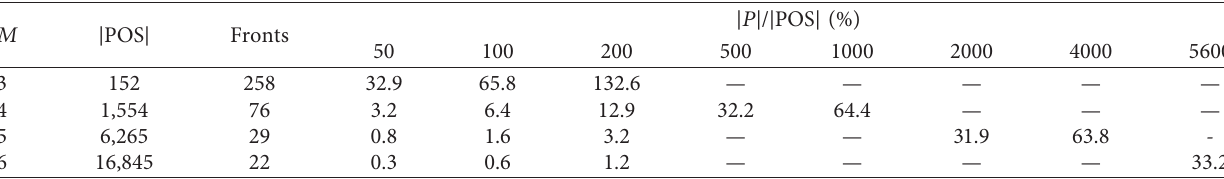
Table 2: Number of solutions in the Pareto optimal set | POS | and nondominated fronts in the landscapes with M � 3 , 4 , 5, and 6 objectives. Also, fraction of | P | / | POS | (in %) for various population sizes | P | investigated in this study. A — indicates that for the corresponding combination of M and | P | , no experiments were performed.